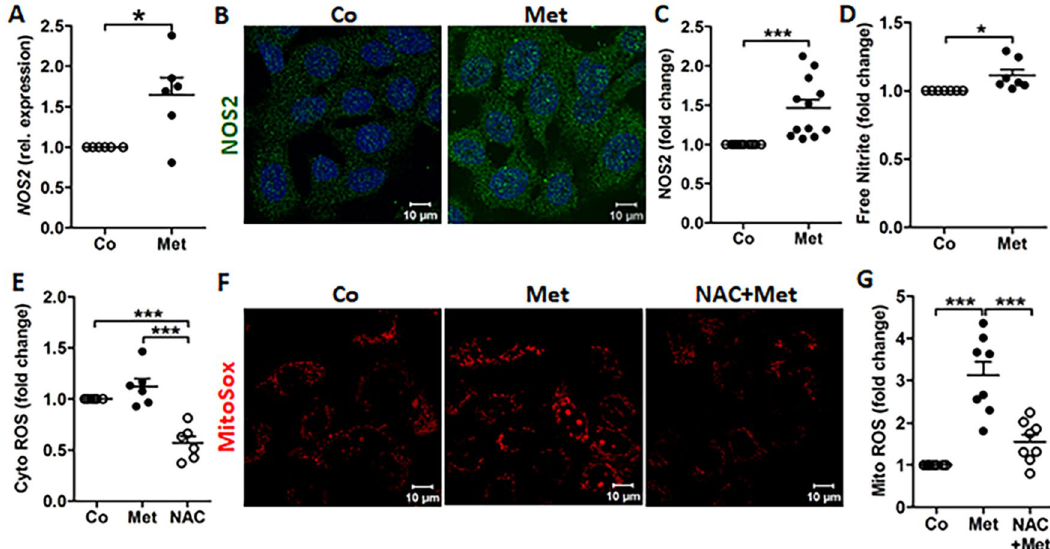
Figure 3. ROS and NO production are stimulated by metformin. ( A ) Expression of NOS2 mRNA (n = 3, performed in duplicates), ( B ) representative images depicting expression of NOS2 enzyme stained with Alexa fluor 488 (green), nucleus stained by DAPI (blue) and ( C ) relative average intensity of NOS2 (n = 3, each consisting of 4 random view-fields). ( D ) Free nitrite was measured in the conditioned media by Griess reagent (n = 4, performed in duplicates). ( E ) Measurement of cytosolic ROS using H2DCFDA, in metformin (Met, 4 mM) or ROS inhibitor N -acetyl-l-cysteine (NAC, 3 mM) treated, untreated cells (n = 3, performed in duplicates). ( F ) Representative mitochondrial ROS images depicting MitoSox Red staining in untreated, metformin or NAC + metformin treated cells (n = 2). ( G ) Average relative intensity of MitoSox Red (n = 2, each consisting of 4 random view-fields). Human uroepithelial cells, 5637 treated with indicated drugs for 24 h. Data are presented as mean with SEM. Significance levels *P < 0.05, ***P <